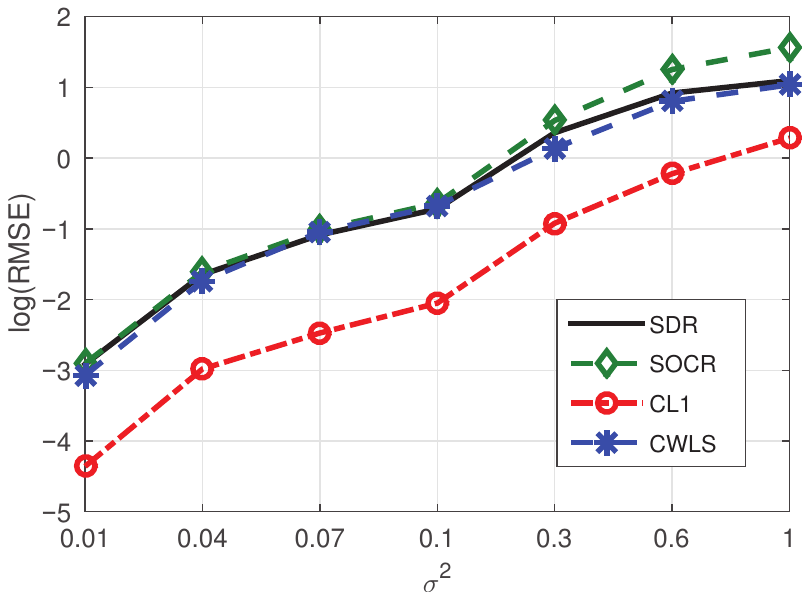
Figure 4. RMSE comparison of four methods under the conditions of seven BSs with noises and one NLOS.